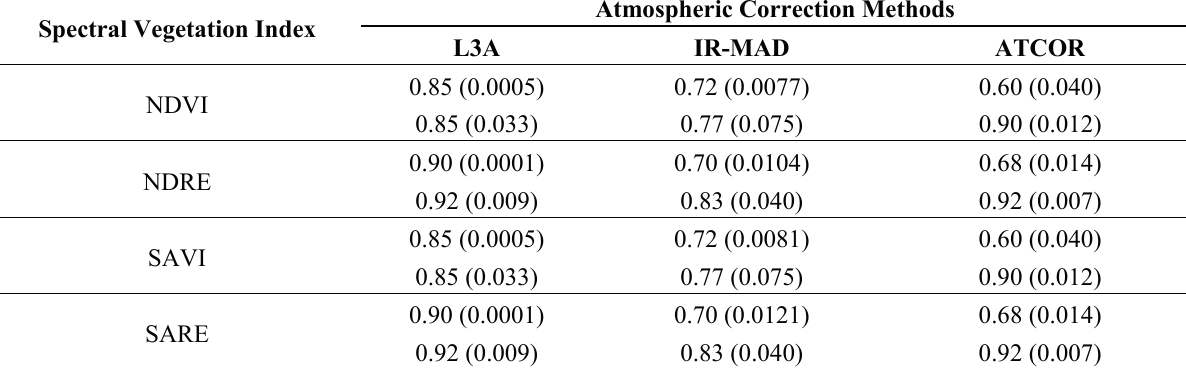
Table 2. Direct comparison of different spectral vegetation indices calculated on RapidEye L3A, IR-MAD and ATCOR processed RapidEye data with LAI destr for winter wheat at two different locations. Top numbers in each cell represent the r for the Selhausen field (2011–2012), the bottom numbers in each cell represent the Merzenhausen field (2011), in brackets the significance level ( p -value) is